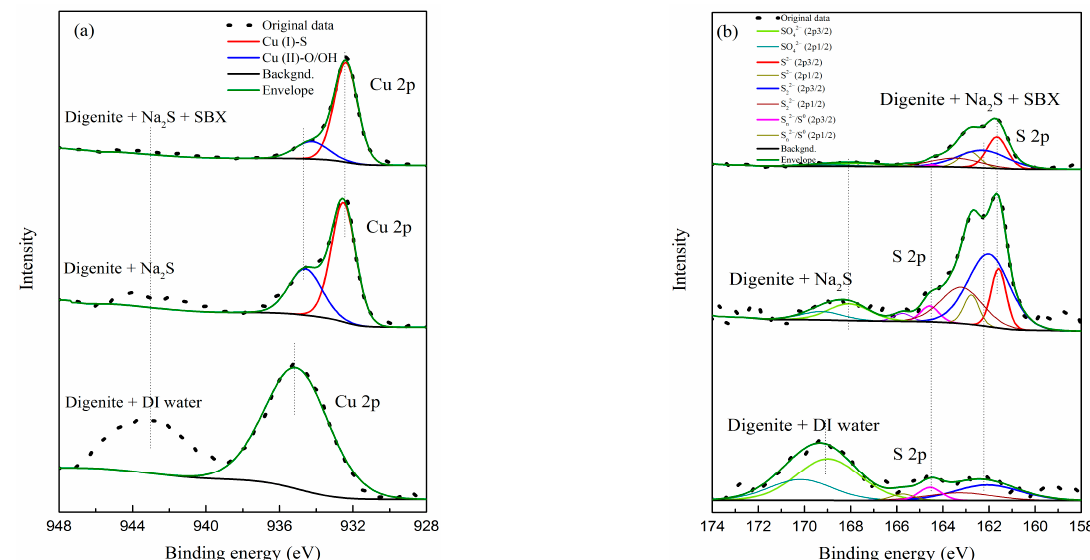
Figure 8. Fitting peaks of Cu 2p ( a ) and S 2p ( b ) for digenite with different treatments in the absence of Fe 3+ (pH: 7.0; Na 2 S dosage: 1.25 × 10 − 3 mol/L; SBX dosage: 1 × 10 − 4 mol/L). Table 1. Cu 2p quantification of digenite with different treatments in the absence of Fe 3+ .